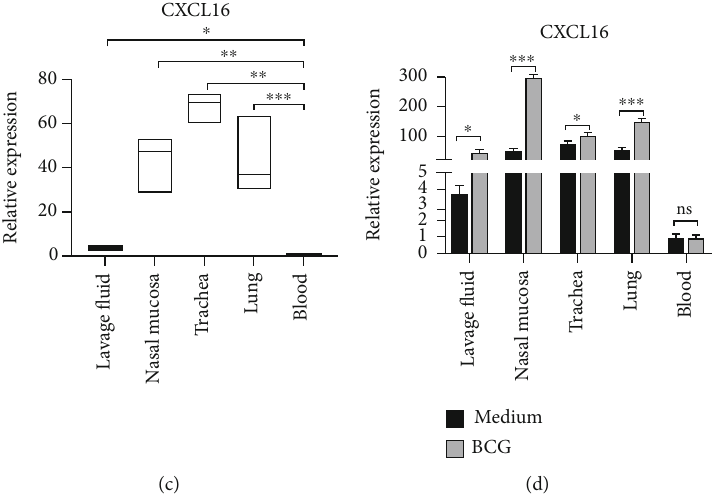
Figure 4: The expression of chemokine receptors between noncirculating T cells and circulating T cells. (a) The frequencies of CX3CR1, CCR2, CXCR3, CXCR4, CXCR5, CCR5, CXCR6, and CXCL16 on noncirculating T cells in nasal mucosa, trachea, and lung tissues and circulating T cells in blood were detected by fl ow cytometry and shown. (b) The statistical results of the frequencies of di ff erent chemokine receptors were analyzed by two-way ANOVA for multiple comparisons. (c) The statistical results of the expression of CXCL16 in the lavage fl uid, nasal mucosa, trachea, lungs, and blood were analyzed by one-way ANOVA for multiple comparisons. (d) After intranasal vaccination with BCG, the statistical results of the expression of CXCL16 in the lavage fl uid, nasal mucosa, trachea, lungs, and blood were analyzed by two-way ANOVA for multiple comparisons. ∗ P < 0 : 05 , ∗∗ P < 0 : 01 , and ∗∗ P < 0 : 001 ; ns: no signi fi